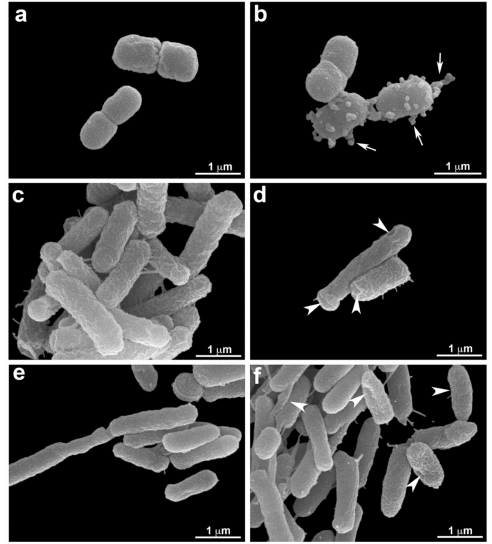
Figure 6. Morphological analysis of O 3 treatment by electron microscopy. A. baumannii ( a , b ), E. coli ( c , d ), and P. aeruginosa ( e , f ) are seen without ( a , c , e ) and under O 3 treatment ( b , d , f ). After treatment, there are membrane protrusions (arrows) are seen in A. baumannii ( b ). Note that control cells exhibit a homogeneous surface ( a ). Both E. coli and P. aeruginosa present surface alterations after treatment ( d , f ). Observing more wrinkle cells is possible than control cells ( c , e ), and some damage is verified